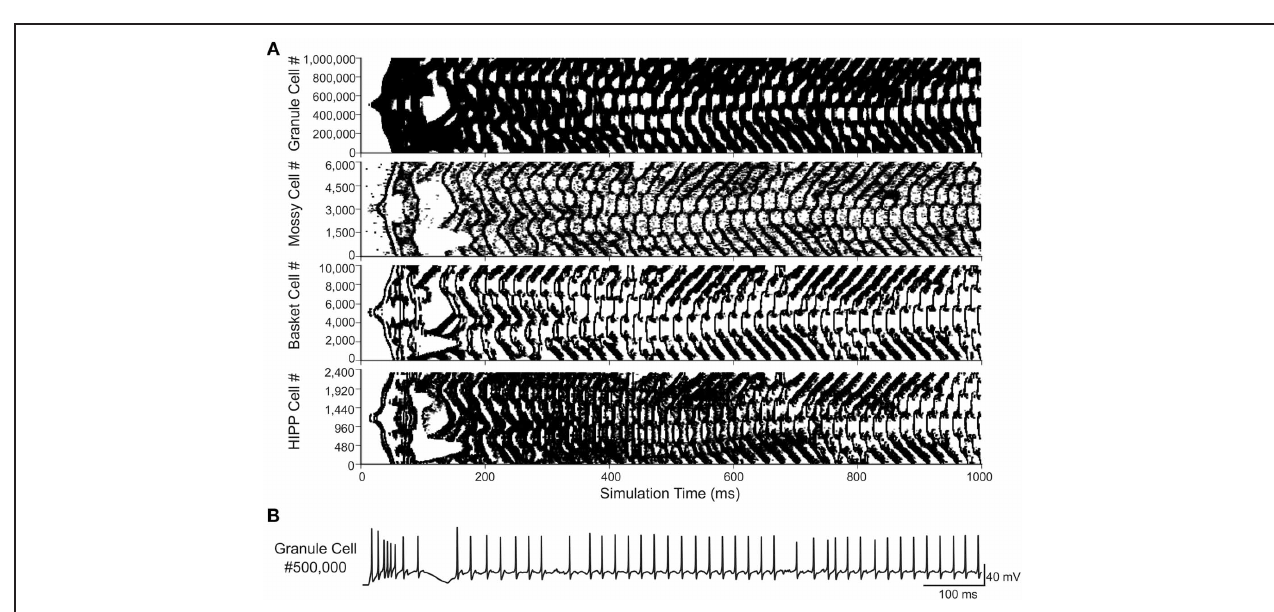
FIGURE 1 | Translation to parallel NEURON. (A) Basic network connectivity of the dentate model. A depiction of the dendritic structure, connectivity, and location of synapses for the four cell types is shown. Note that the septo-temporal extent of the axons is also incorporated into the model (see Dyhrfjeld-Johnsen et al., 2007) but is not illustrated here. In the injured model, HIPP cells and mossy cells are lost, while granule